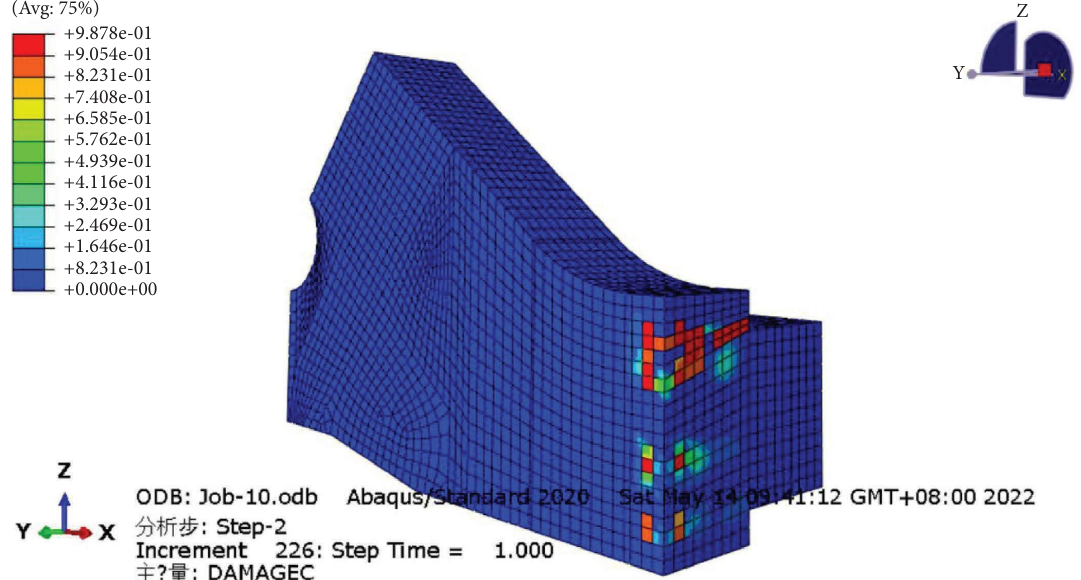
Figure 14: Cloud chart of concrete compression plastic damage of condition 17.